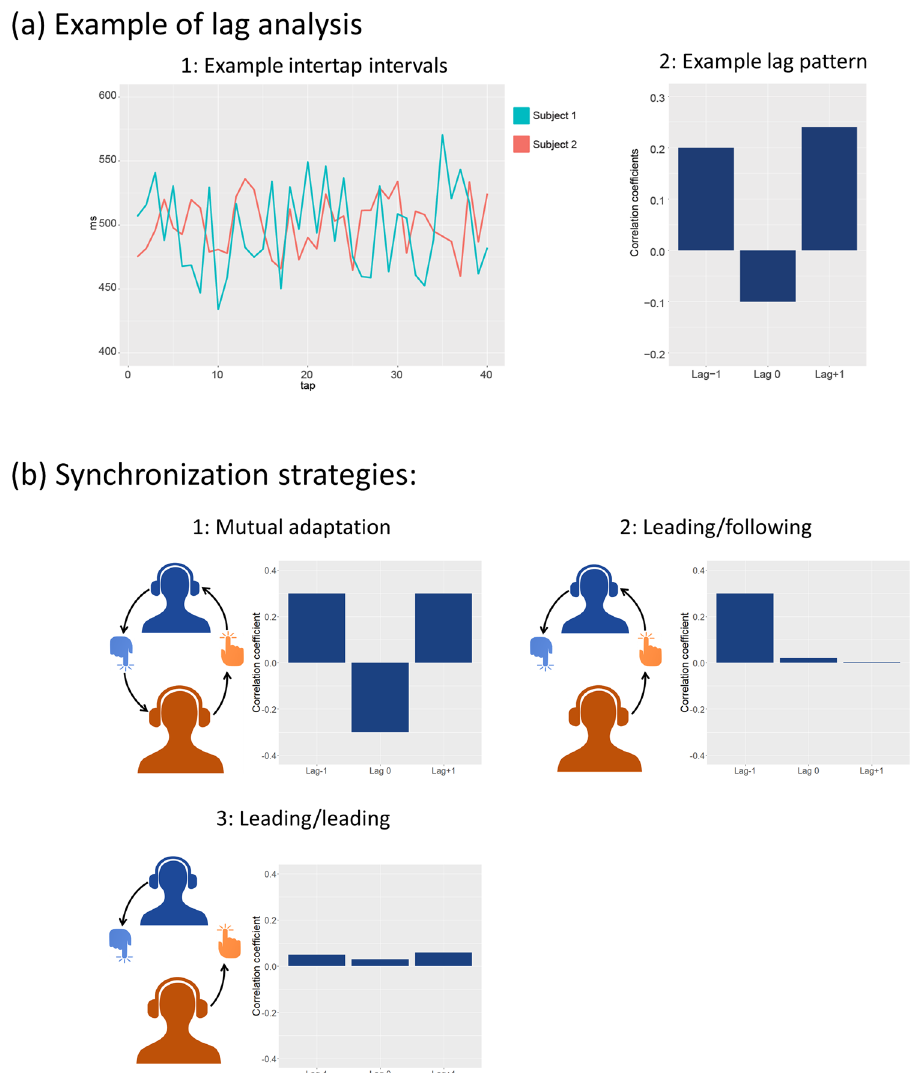
Figure 3. ( a ) An example of the lag analysis. Here, simulated data is shown exhibiting a mutual adaptation dynamic. In the first graph the ITI of a simulated sequence is shown. Cross-correlation is performed on the ITI timeseries, giving correlation coefficients for lag − 1, 0 and + 1. ( b ) An illustration of different synchronization strategies and their corresponding lag patterns. Mutual adaptation occurs when a perception-action loop is formed between the two members of a dyad, such that they equally weigh the incoming auditory stimuli from the other member, and their own model of the task. Leading-following depends on one of the dyad members to attenuate the information coming from the other member, here illustrated by the missing connection between the blue member’s tapping and the orange member’s headphone. As such, the leader puts more confidence in their own internal model. In the case of leading-leading, as observed in our experiment, both participants exhibit leading behaviour. Here, they both discard information from the other member and rather relies on their own